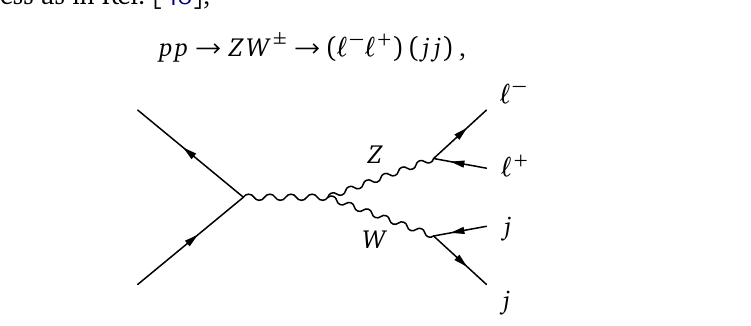
Figure 1: Sample Feynman diagram contributing to ZW production, with intermedi- ate on-shell particles